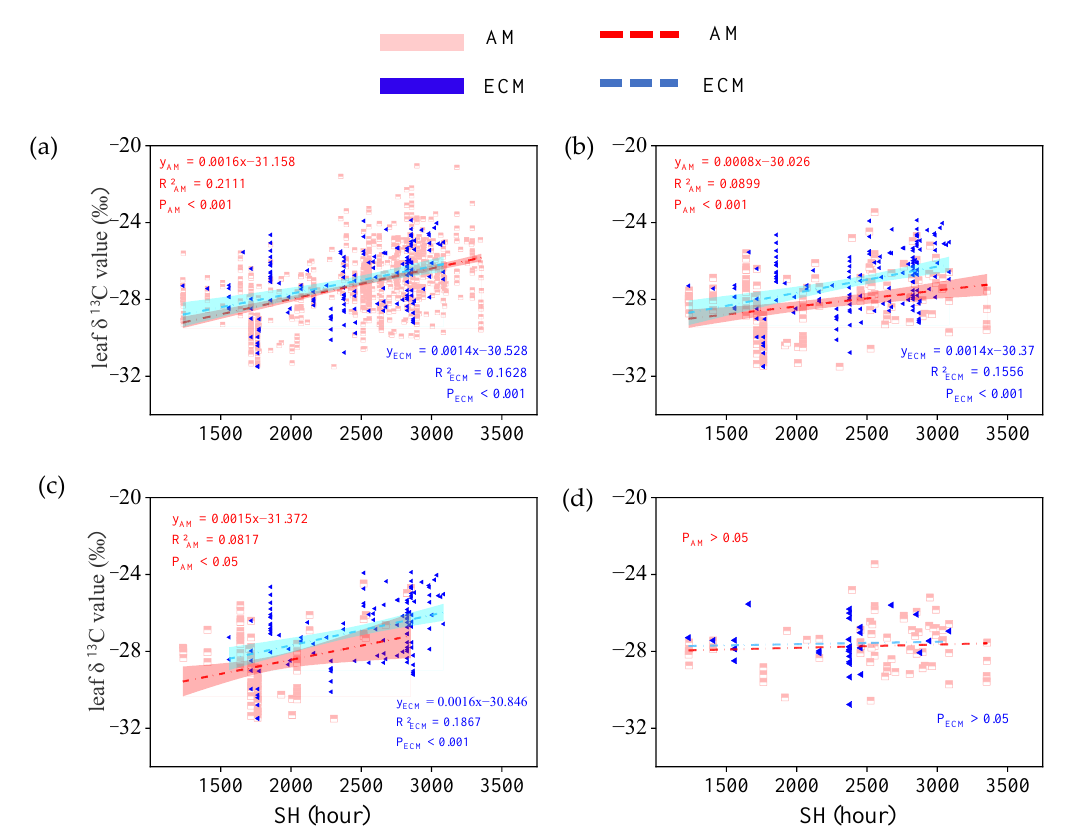
Figure 8. The relationship between leaf δ 13 C in AM plants and ECM plants with different life forms and sunshine hours (SH, hours). ( a ) Total plants, i nclude all plants in the database without distin- guishing their life forms. ( b ) trees, o nly contain all the tree species in the database. ( c ) evergreen trees, only contain all evergreen trees of the tree species. ( d ) deciduous trees, only contain all decid- uous trees of the tree species. The red broken line means AM, the blue broken line means ECM. The red and cyan bands represent, respectively, the prediction intervals of AM and ECM plants. P( AM and ECM ) represents the significant difference in the slope of the two regression lines.